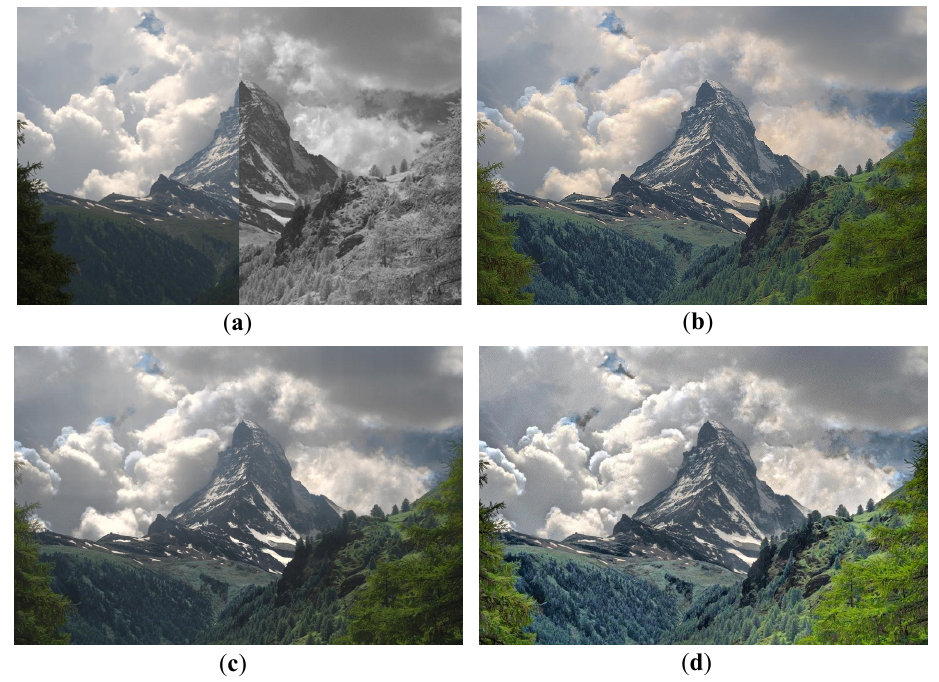
Figure 8. Input image pair and resulting images: ( a ) input VIS and NIR images, ( b ) Laplacian pyramid fusion [1], ( c ) low-rank fusion [5], and ( d ) the proposed method.